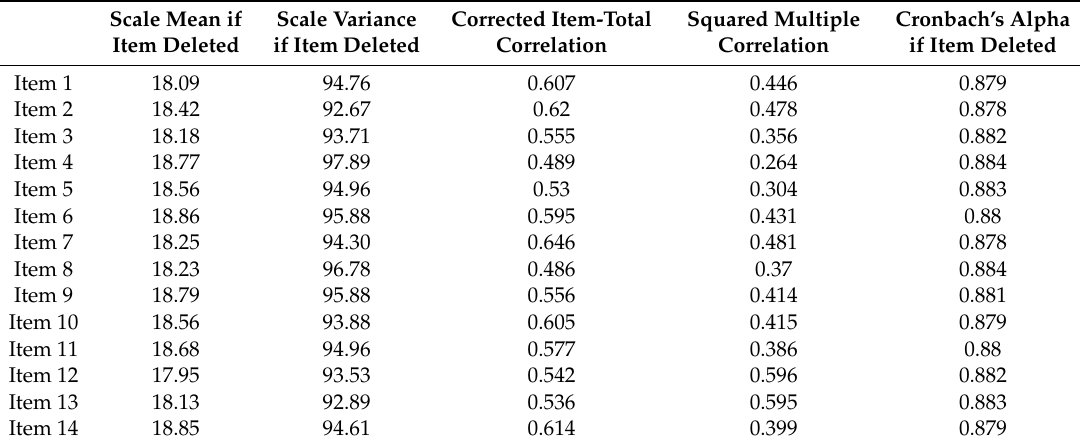
Table 3. Item-total